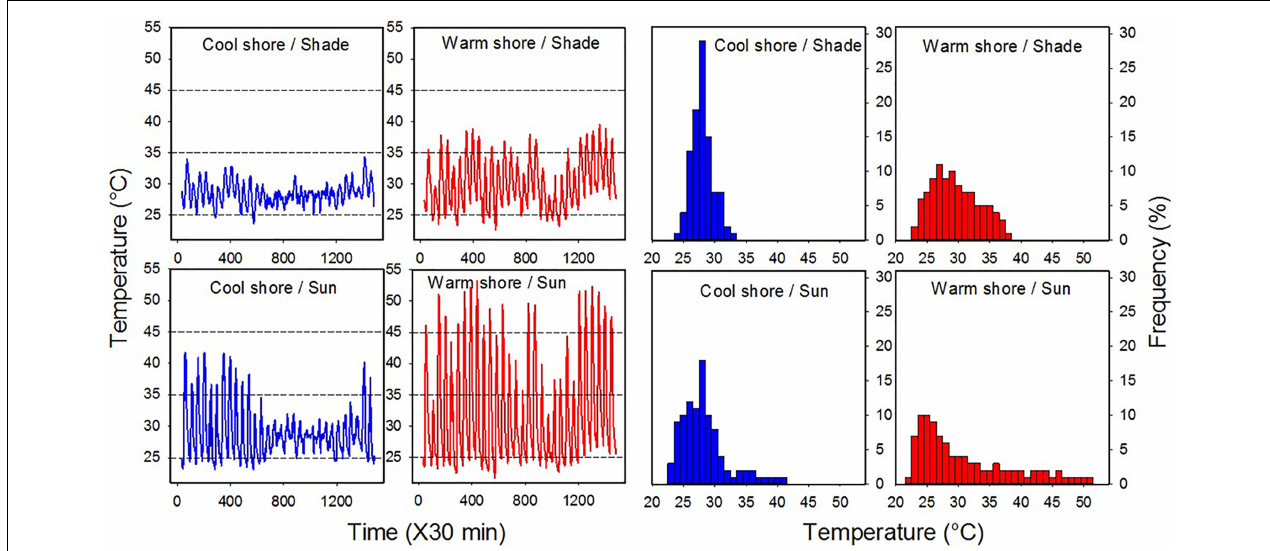
FIGURE 2 | Daily field temperature regimes and thermal frequencies for the four habitats (cool shore, CS, sun and shaded, and warm shore, WS, sun and shaded). All data were logged using DS1923-F5# Hygrochron I-buttons over 30 days. Temperatures were recorded between 21 June and 22 July 2018 at the sites where snails were collected (see Supplementary Figure S1